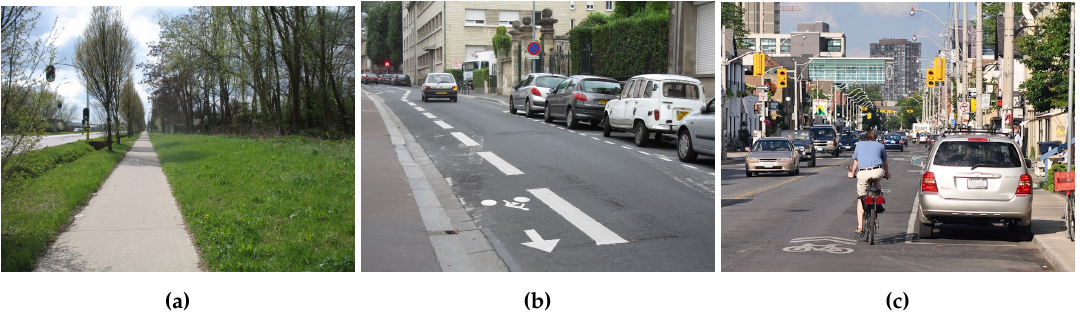
Figure 9. Representation of the cycleway: ( a ) track, a separate cycle path. ( b ) lane, on-road cycle path. ( c ) shared, a common path with other